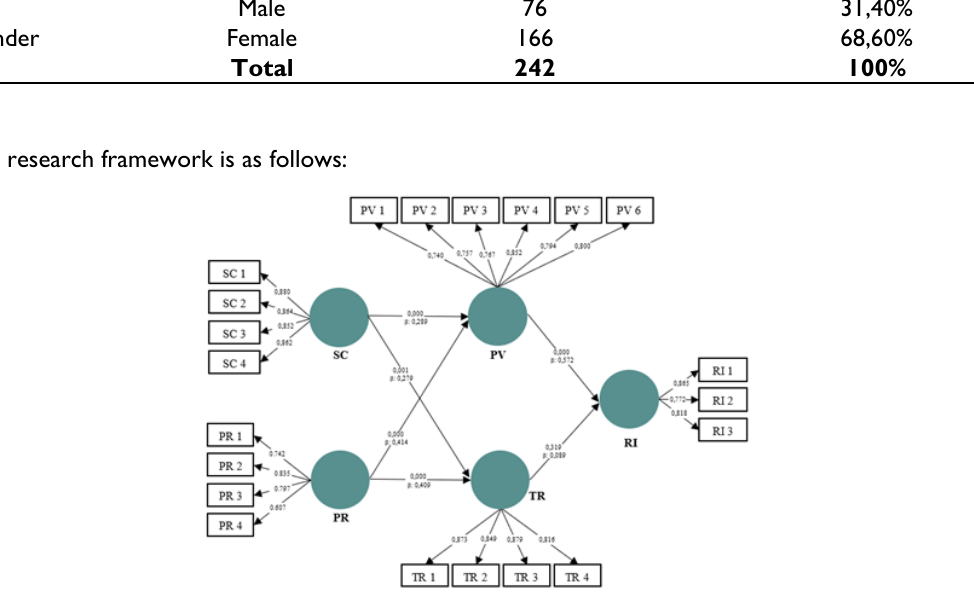
Figure 2. Conceptual